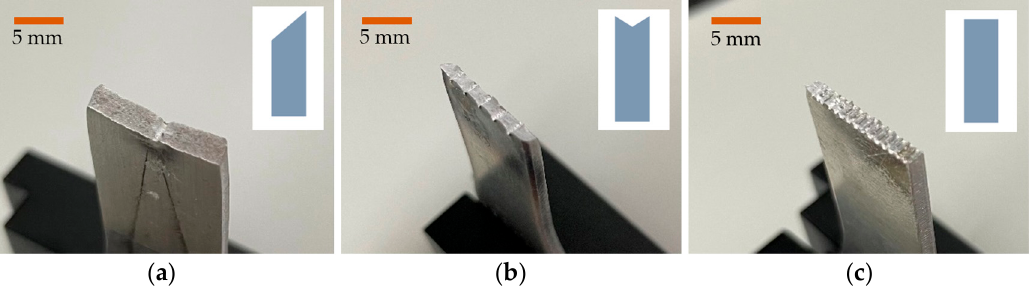
Figure 4. Tensile fracture morphology of specimens with different number of holes by laser ablation, ( a ) 45° oblique fracture, ( b ) U-shaped fracture, ( c ) flat fracture. The top right corner of the image shows a diagram of fracture morphology.